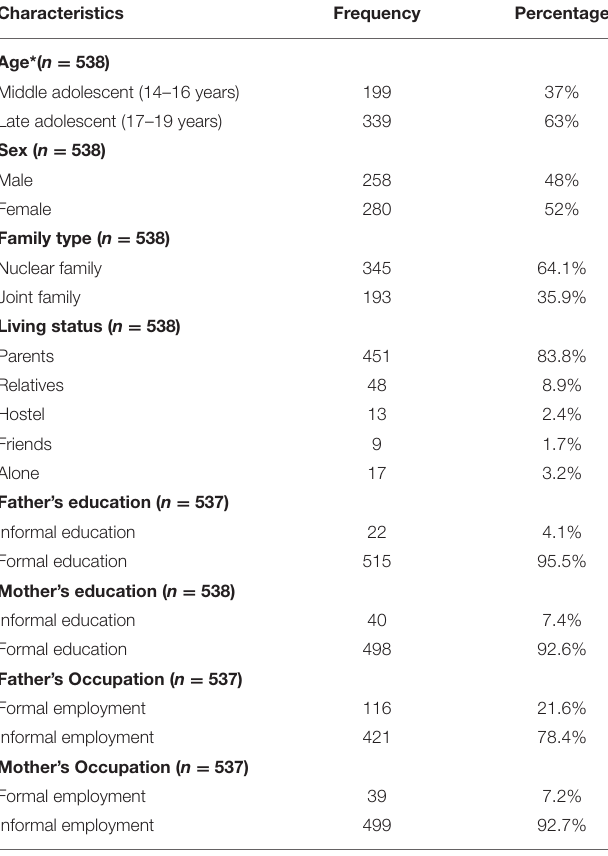
TABLE 2 | Sociodemographic characteristics of participants ( n = 538).